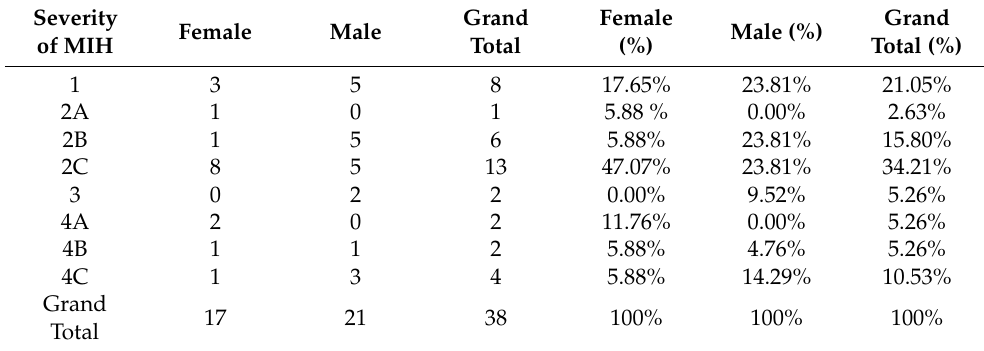
Table 5. Severity of MIH according to the Wurzburg concept (MIH-TNI).